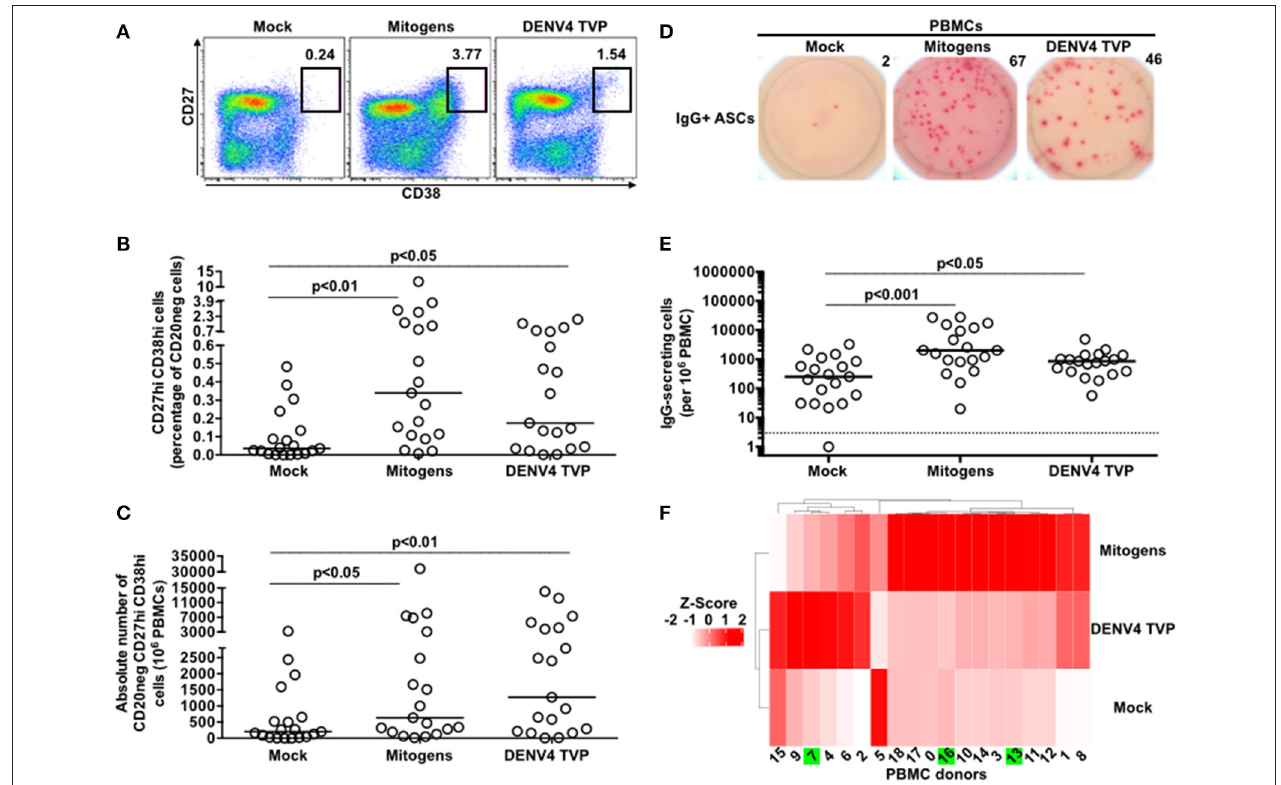
FIGURE 1 | Dengue virus promotes the B cell differentiation into antibody-secreting cells (ASCs) in vitro disregarding pre-existing DENV immunity. (A) Representative FACS data displaying the percentage of cells with the ASC phenotype at day 7 of culture. (B,C) Percentage and absolute number of ASCs quantified through FACS for different PBMC cultures derived from 19 healthy donors. (D) Representative data obtained from 3.3 × 10 4 PBMCs harvested at day 7 of culture and added per well of ELISPOT plates to enumerate IgG-secreting cells in each culture condition. (E) Magnitude of IgG-secreting cells detected per 10 6 PBMCs through ELISPOT. (F) Heatmap based on Z scores derived from ELISPOT data for each culture condition. Green boxes represent the PBMC donors that presented pre-existing immunity to DENV.